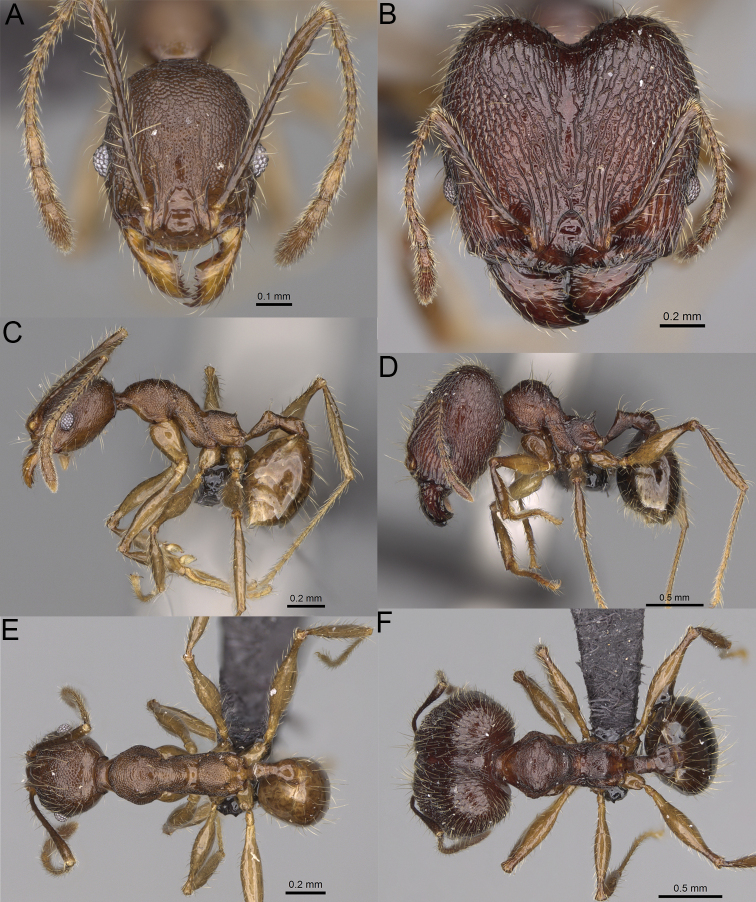
Pheidole
veteratrix Forel, full-face view (A), profile (C), and dorsal view (E) of minor worker (CASENT0923259) and full-face view (B), profile (D), and dorsal view (F) of major worker (CASENT0148662).